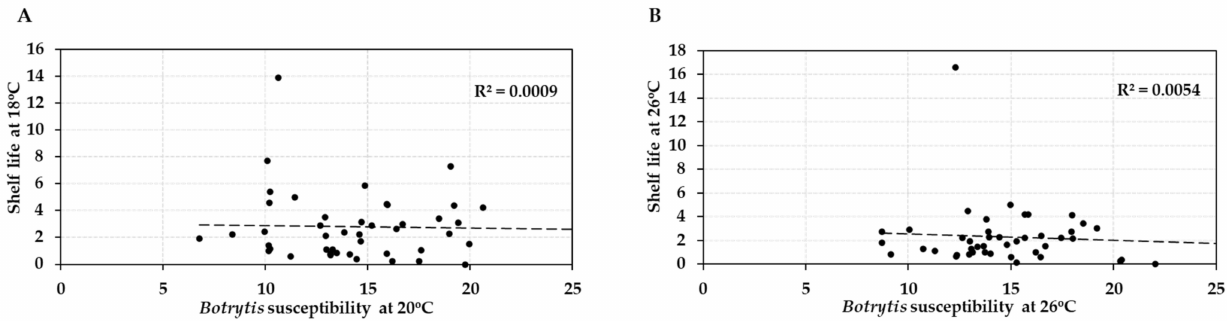
Figure 4. Correlation analysis of post-harvest properties of 41 tomato accessions (HT and HS) at normal vs. elevated temperature. ( A ) Average shelf life (in weeks) at 18 ◦ C vs. 26 ◦ C. ( B ) Botrytis susceptibility (average lesion size in mm at 3 dpi) at 20 ◦ C compared to 26 ◦ C.